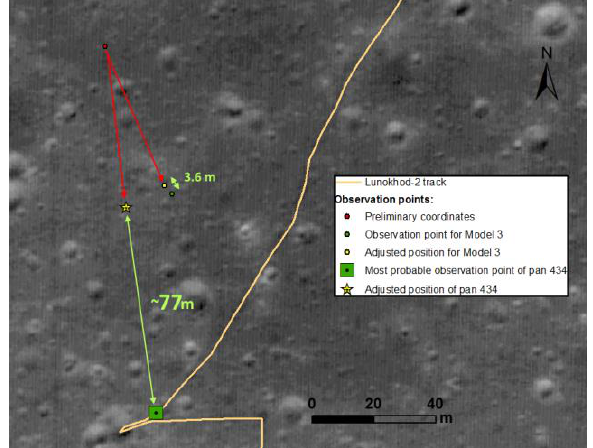
Figure 4. Observation points of Model 3 and panorama #434: preliminary (red), obtained from adjustment (yellow) and real (green) positions.